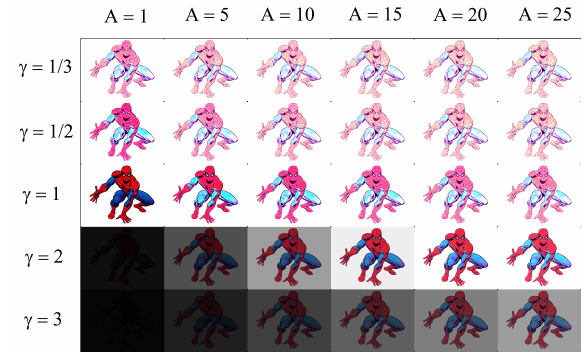
Fig. 2. Original figure at A = 1 and γ = 1